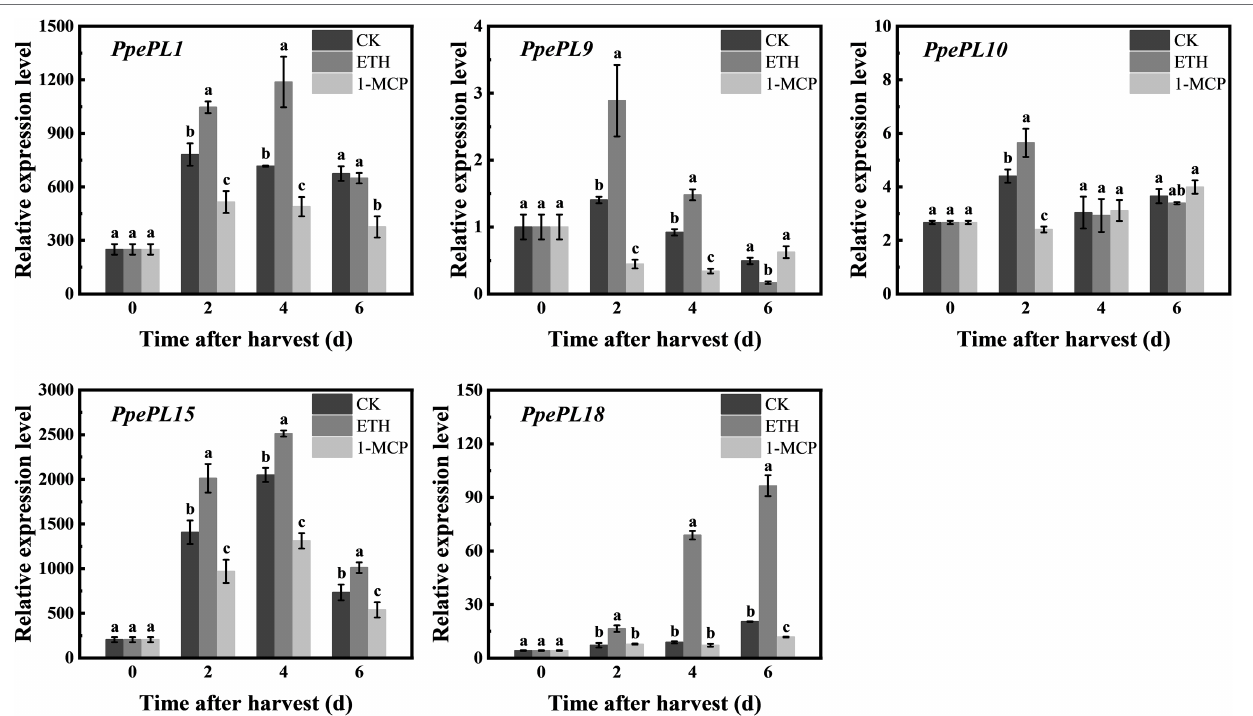
FIGURE 6 | Relative expression of PpePL1, 9, 10 15, and 18 in response to ethylene and 1-MCP treatment in cv. “QJB” fruit during storage. PpTua5 and PpCYP2 served as reference gene. Each values represents the means ± standard error of three replicates. Significant differences ( p < 0.05) between means are indicated by different letters. “QJB”, “Qian Jian Bai”; ETH, ethephon treatment; 1-MCP, 1-Methylcyclopropene treatment; CK,